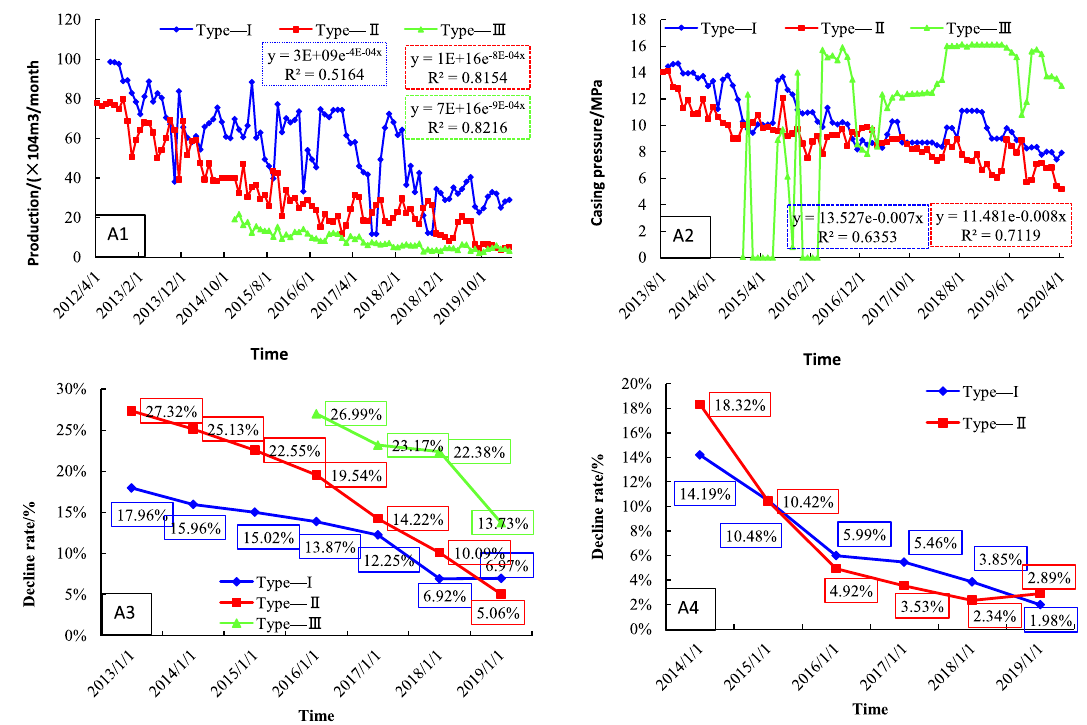
Fig. 14 Decline pattern of wells (A1: production; A2: surface casing pressure; A3: production decline rate; A4: decline rate of surface casing pressure)